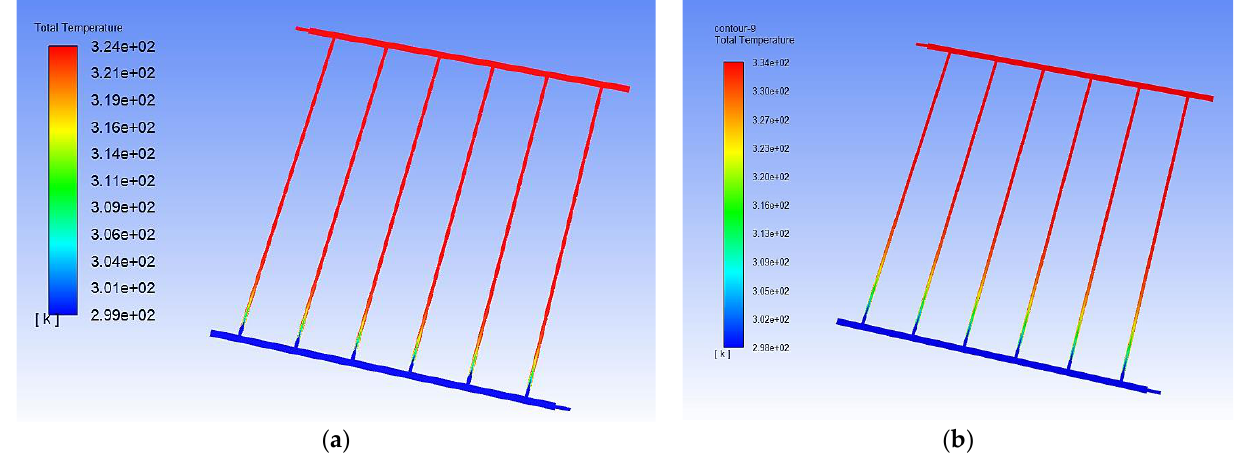
Figure 5. ( a ) Low mass flow rate with low temperature; ( b ) high mass flow rate with high temperature.